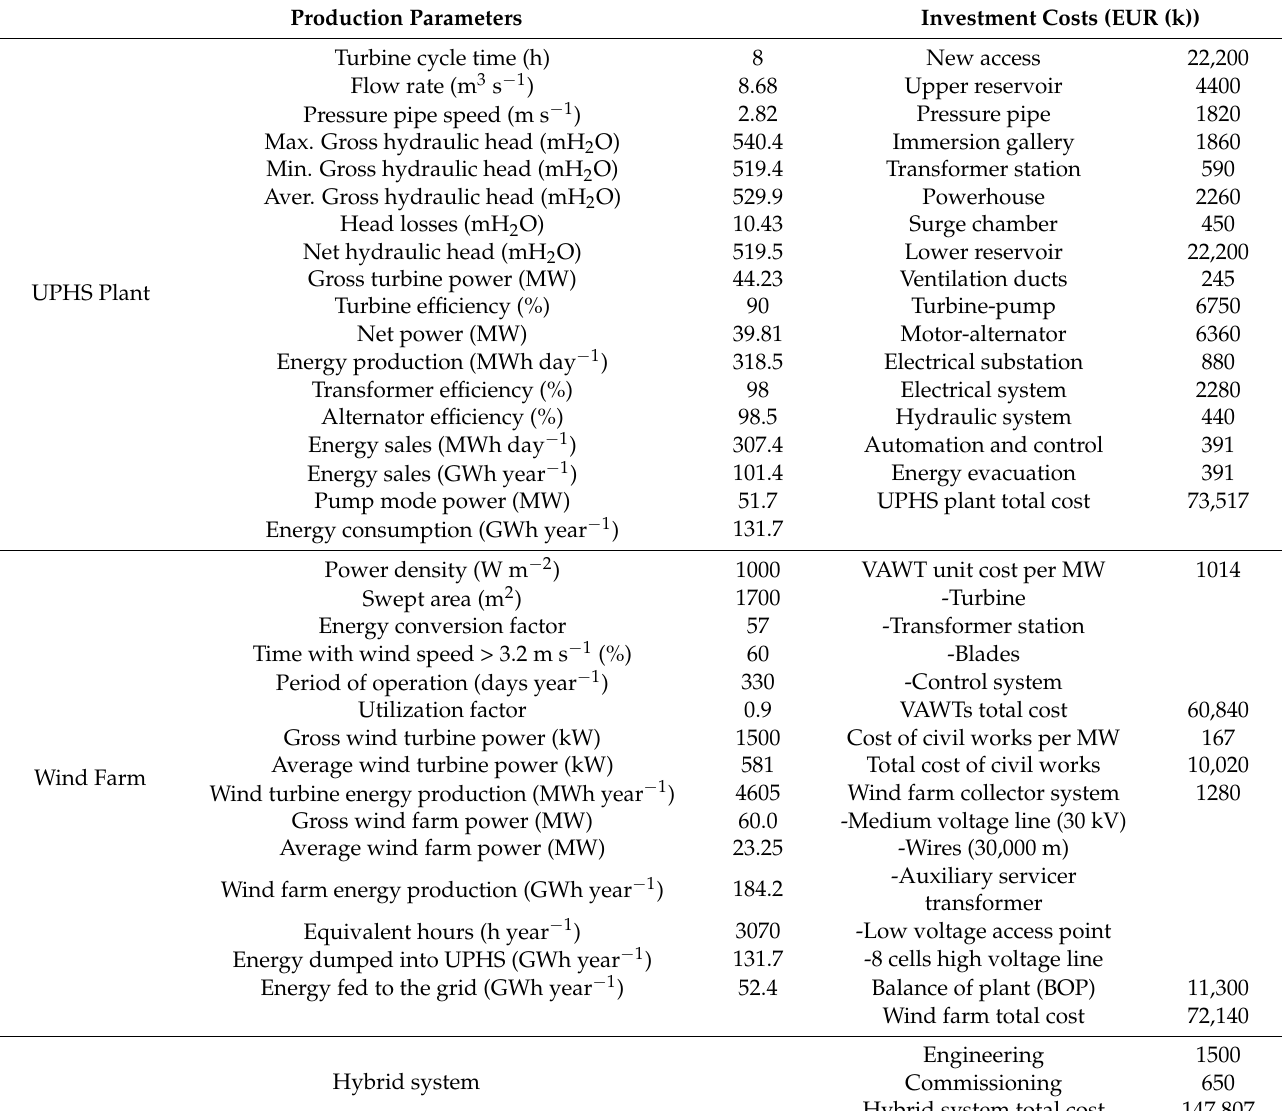
Table 2. Production parameters and the investment costs of the hybrid